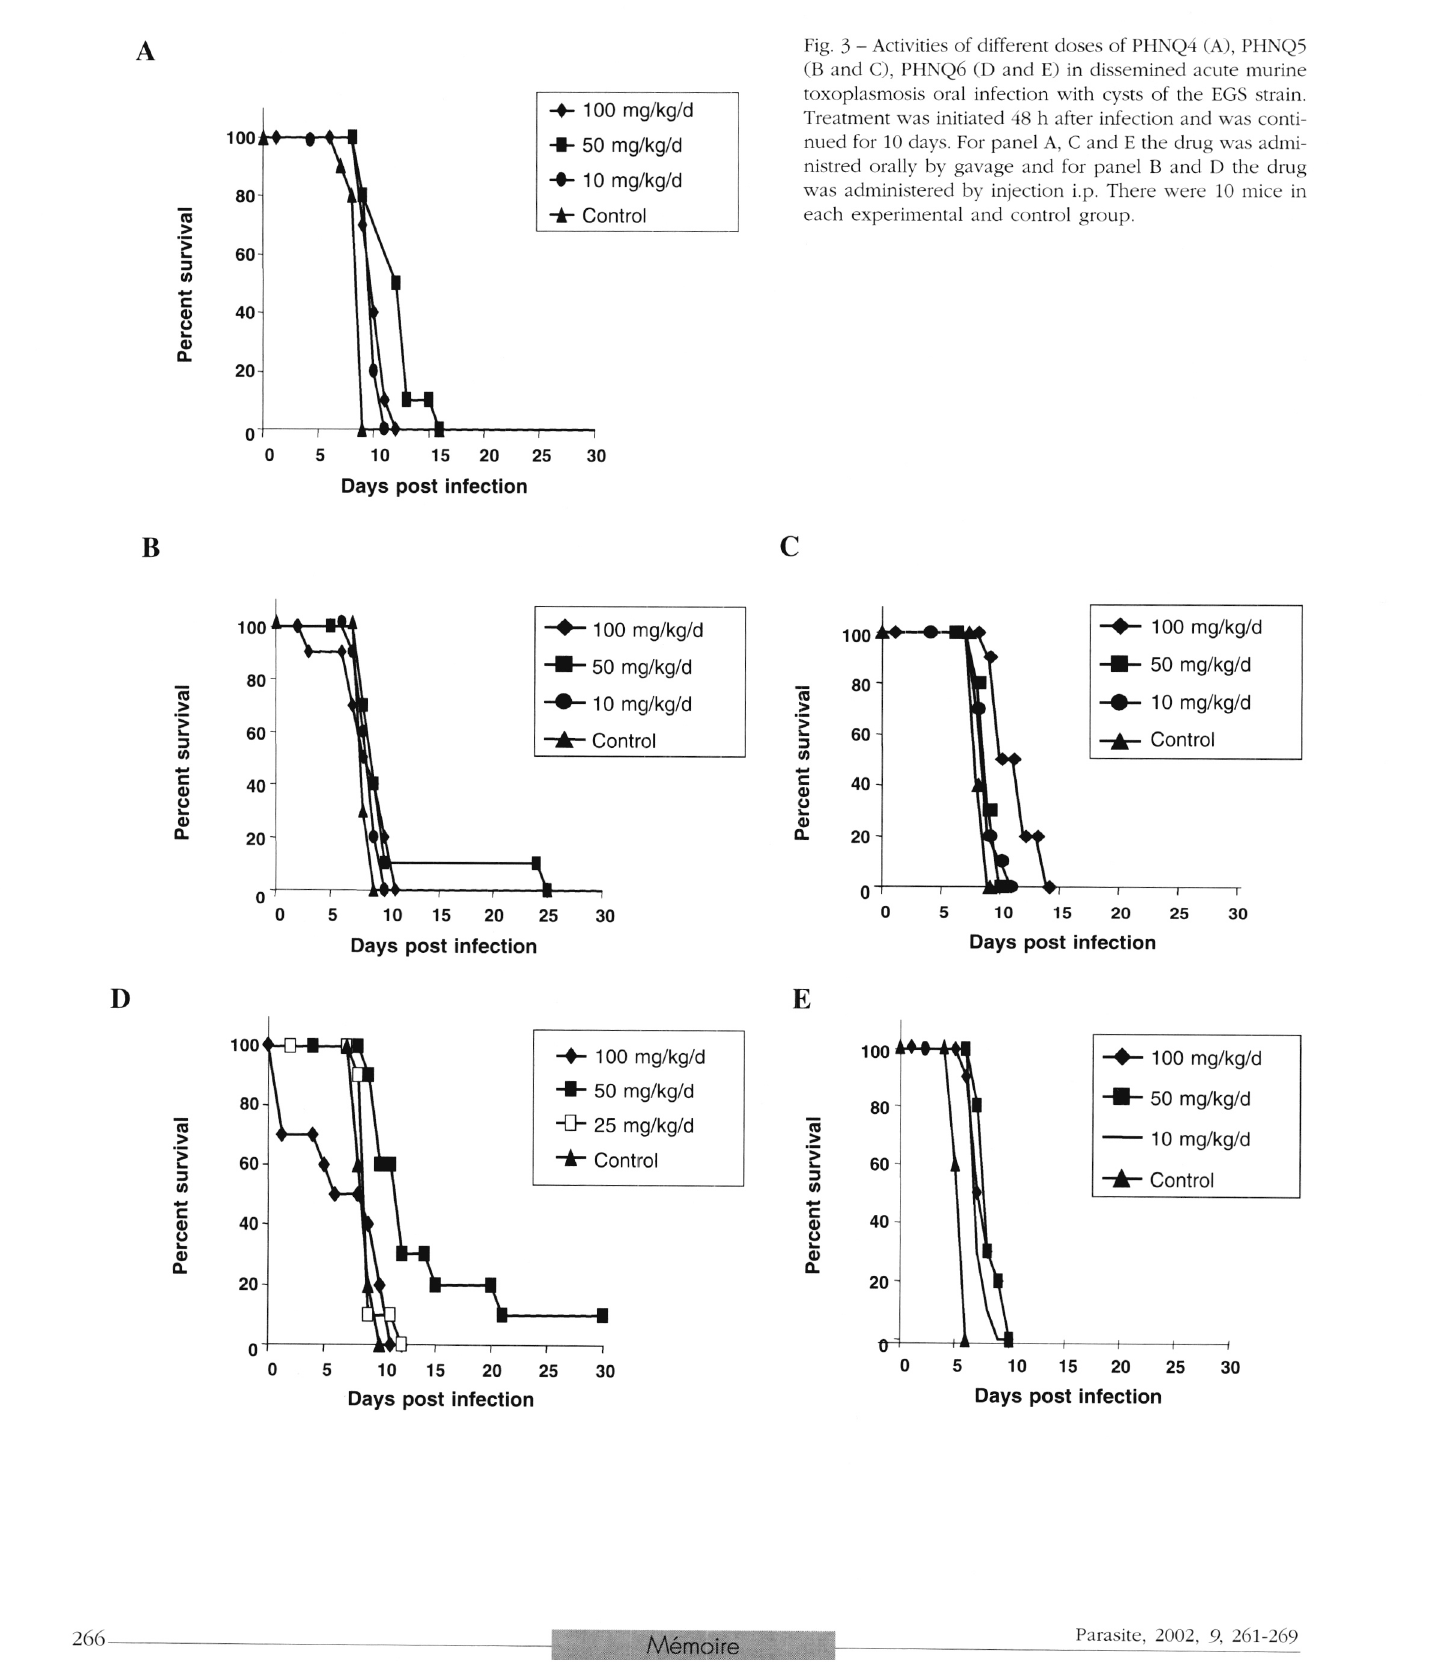
Fig. 3 - Activities of different doses of PHNQ4 (A), PHNQ5 (B and C), PHNQ6 (D and E) in dissemined acute murine toxoplasmosis oral infection with cysts of the EGS strain. Treatment was initiated 48 h after infection and was conti­ nued for 10 days. For panel A, C and E the drug was admi- nistred orally by gavage and for panel B and D the drug was administered by injection i.p. There were 10 mice in each experimental and control